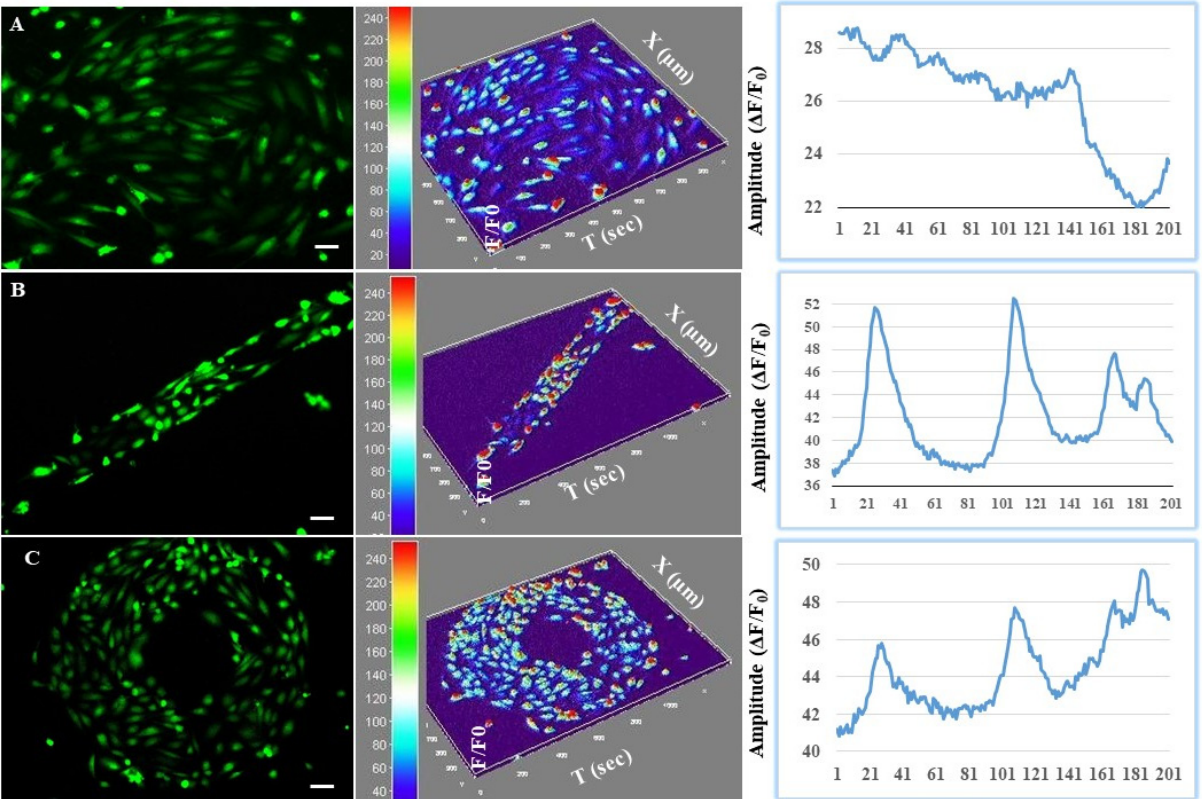
Figure 5. Induced spontaneous calcium sparks in the upper panel ( A ) from unpatterned control endothelial cells. The middle panel shows the patterned endothelial–astrocyte co-culture ( B ) line patterns and the lower panel ( C ) the ring patterns (scale bar: 50 µm). The left column exhibits spontaneous calcium release events stained with Fluo-4-AM, the middle column shows the average intensity-based pseudo-colored topographical map showing the calcium level in individual cells, and the right column shows the ImageJ sparkmaster-extracted intensity features of the calcium sparks to plot the quantitative curves for control unpatterned vs. patterned co-cultures.